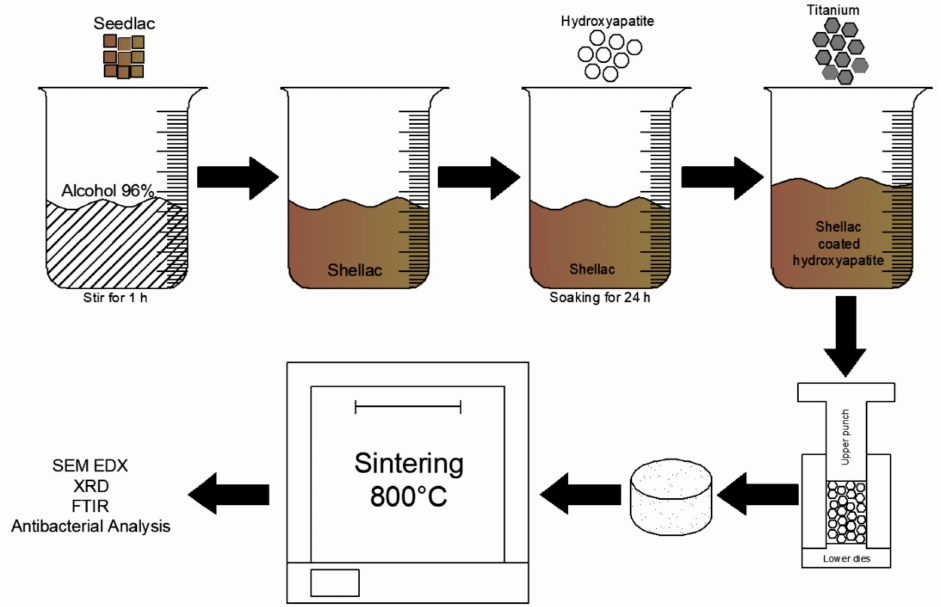
Figure 1. Ti-HA composite sample preparation.